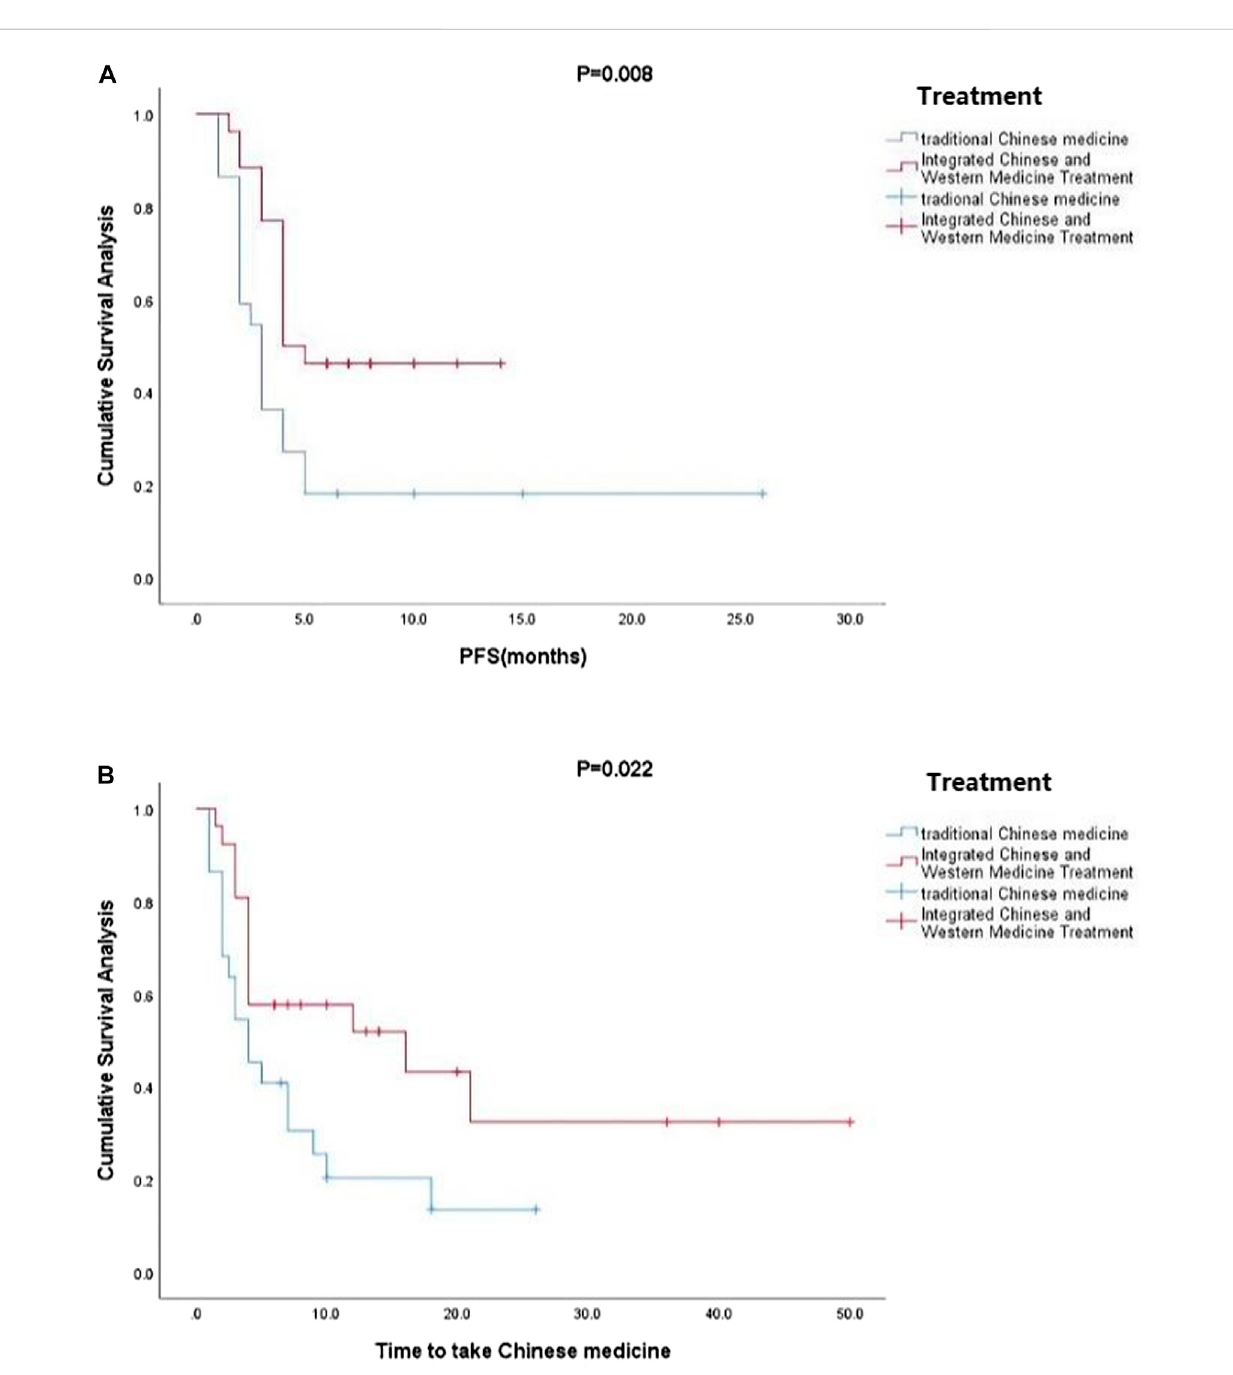
Kaplan-Meier plots showing (A) PFS and (B) TTCM according to whetheror not TCM was combined with conventional Western chemotherapy. PFS, progression-free survival; TTCM, total duration of traditional Chinese